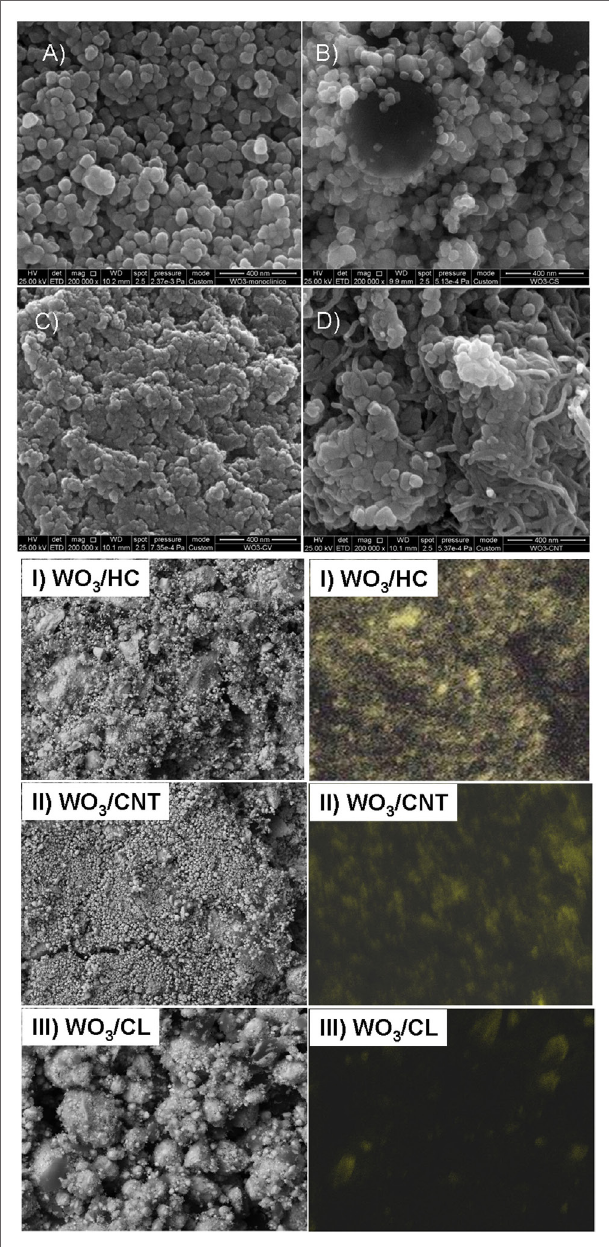
FigUre 1 | seM images (a–D) and eDX mapping (i, ii, iii) showing the distribution of the carbon additives on the photocatalysts: (a) WO 3 , (B) WO 3 /hc, (c) WO 3 /cl, (D) WO 3 /cnT